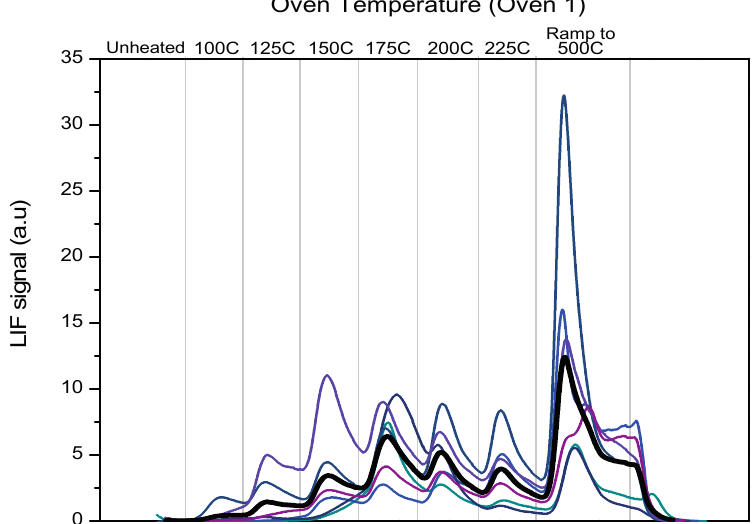
Figure 1. Six programmable thermal dissociation (PTD) profiles using Oven 1 program for an uncoated tubular denuder loaded with pure HgCl for 1 min at 135 sccm. The average of the six profiles is also over pure HgCl 2